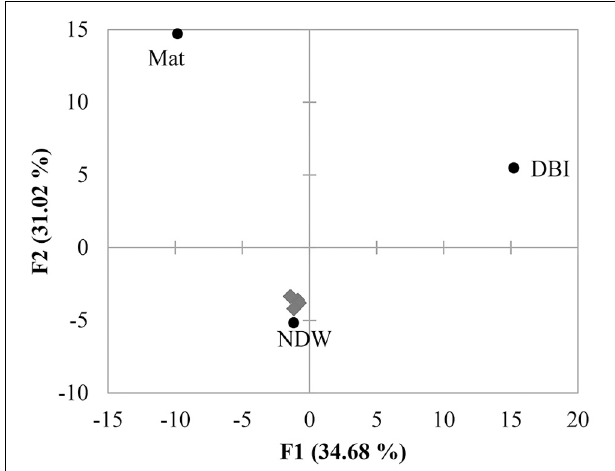
FIGURE 3 | Principal component analysis (PCA) of OTUs. The 18S amplicon reads were clustered into OTUs at a dissimilarity of 20%. As shown in Figure 2 , the distribution of the reads in the clades was used to perform PCA. The 4 sediment samples (gray diamonds) were grouped with the normal sea water above the seafloor